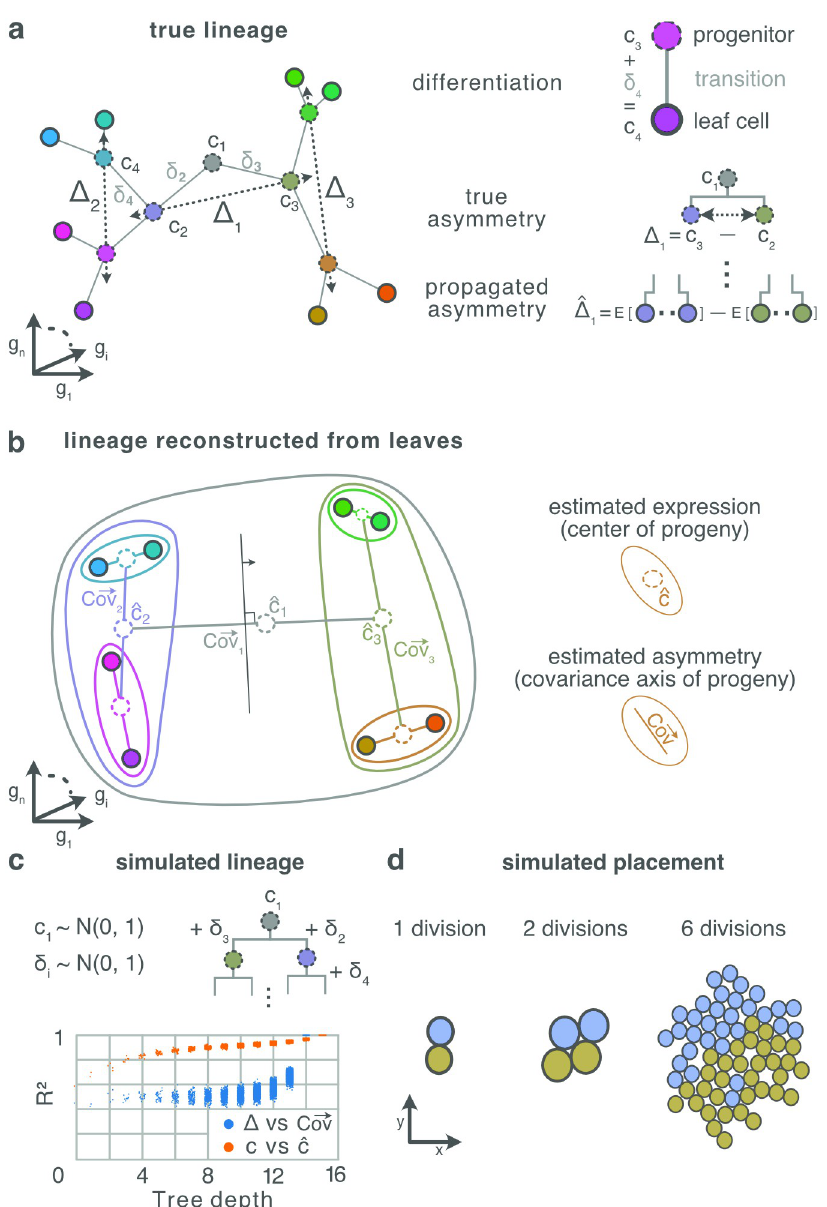
Fig 3. A Cells are points positioned in high-dimensional expression space, where each axis represents the expression of one gene. Here, this high-dimensional space is reduced to 2D dimensions for plotting purposes, so that their 2D distance approximates their high-dimensional distance. In our division model, the differential expression between a parent cell c 1 and its daughters c 2 , c 3 is a normally distributed random vector representing the genetic state transition from parent to daughter, denoted δ 2 = c 2 − c 1 . (Here we use the division of the root progenitor 1 as a running example for any division.) The differential expression between two siblings, which we call the parent’s asymmetry, is denoted Δ 1 = c 3 − c 2 = δ 3 − δ 2 . As a result, the correlation in gene expression between two cells reflects their distance through the lineage tree. (See C for verification of this process by numerical simulation.) B The expression of a progenitor can be estimated as the mean expression over its leaf progeny; and the asymmetry of a progenitor can be measured as the main axis of variance across its progeny. The diagram shows only the leaves of the lineage tree show in A —they have identical positions in embedded expression space. Each nested contour encloses the progeny of a progenitor; lines within the contour indicate the main axis of variance across the enclosed progeny; and dotted circles the average expression across the progeny. The sets of progenies for individual progenitors can be obtained by iteratively splitting the progeny along their main axis of variance, so with a decision boundary (black line with arrow) orthogonal to this axis. C Numeric simulation of expression profiles induced by our division model, and subsequent reconstruction